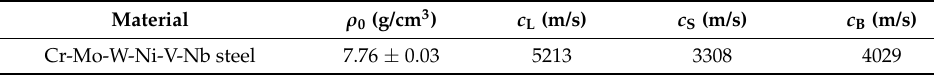
Table 1. Material properties of the HSLA.